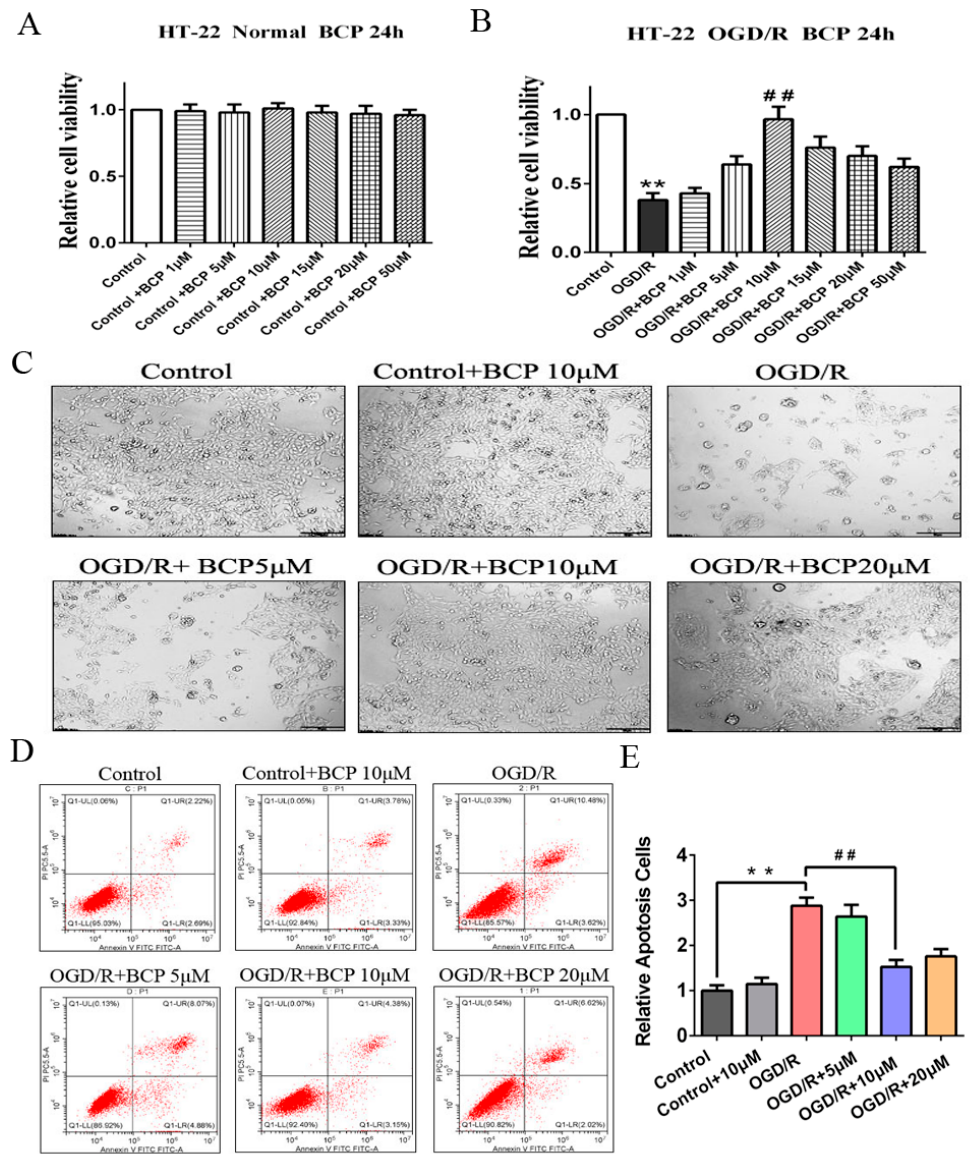
Figure 1. BCP alleviated OGD/R injury-induced decreases of cell viability and apoptosis. ( A ) Role of BCP on cell viability of HT-22 cells (normal condition). ( B ) Role of BCP on cell viability of OGD/R cells. ( C ) HT-22 cells were observed by microscopy after treatment with varying doses of BCP (OGD/R, 24 h). ( D ) BCP reduced the apoptosis of OGD/R cells, as indicated by flow cytometry. ( E ) Quantitative analysis of flow cytometry results. ( n = 3; ** p < 0.01 OGD/R group vs. control group; ## p < 0.01 OGD/R + BCP 10 µ M group vs. OGD/R